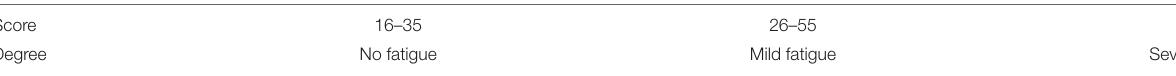
TABLE 6 | Correspondence table between MFI-16 scale scores and 3 types of fatigue levels.